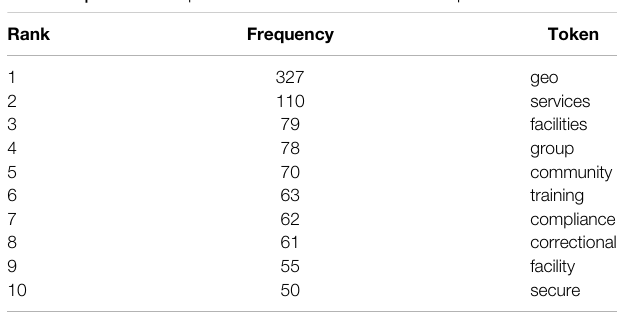
TABLE 3 | 10 most frequent content words in the GEO corpus.